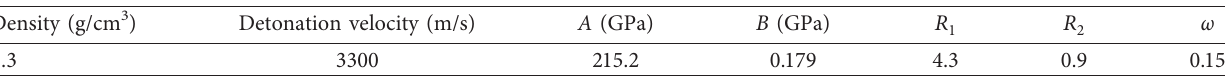
Table 2: Parameters of the explosive and its equation of state.